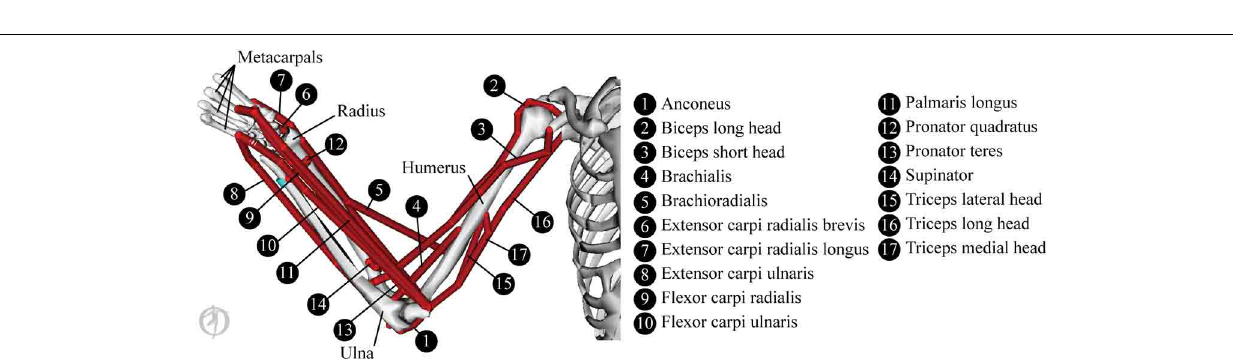
FIGURE 3 | The musculoskeletal model, showing the paths of the 17 muscles modeled